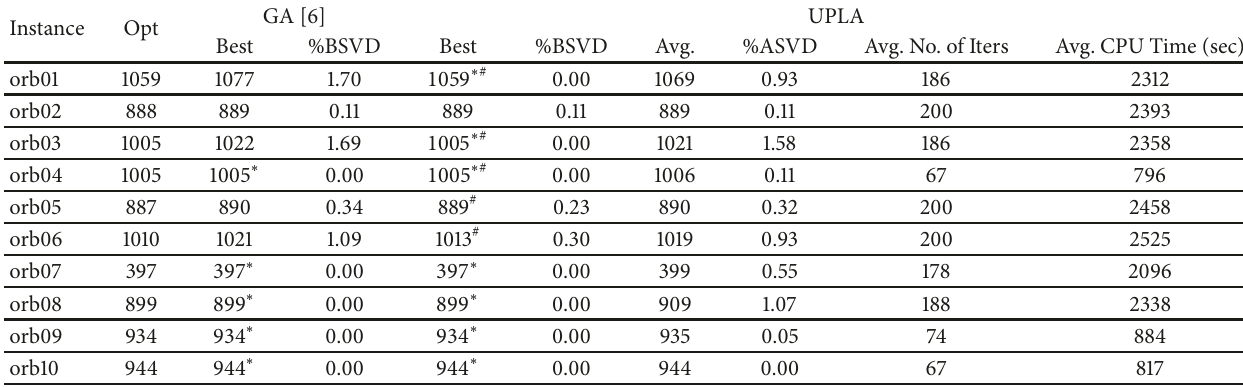
Table 3: Experiment’s results on the set of orb